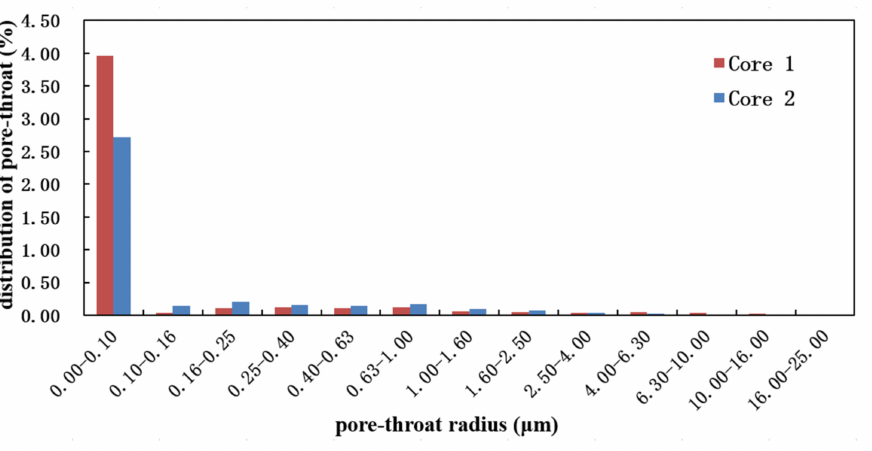
Figure 3. The pore-throat distribution of